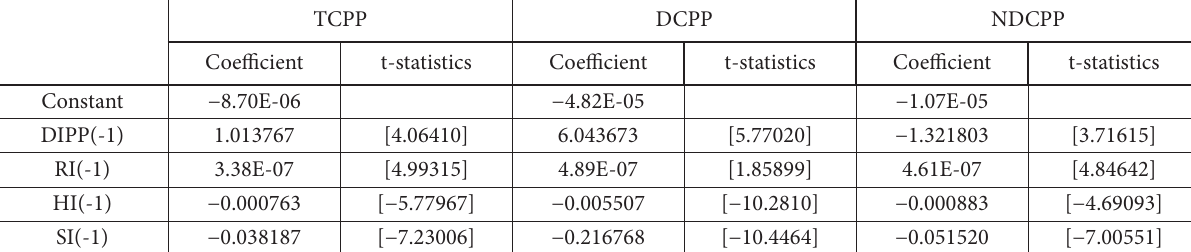
Table A1. Vector error correction model for main categories of consumption (long-term equilibrium